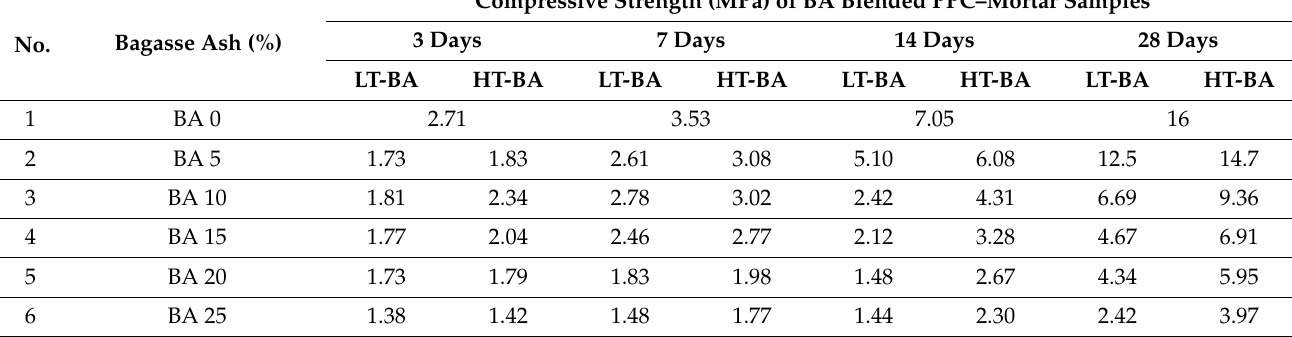
Table 5. Compressive strength of bagasse ash (BA)-blended PPC mortars at early curing ages, 3–28 days; BA amount from 0 to 25% of PPC replacement.